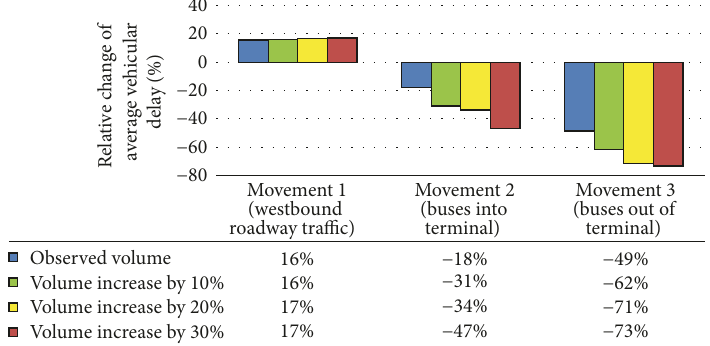
Figure 13: Effects of second alternative design on the average delay (traffic